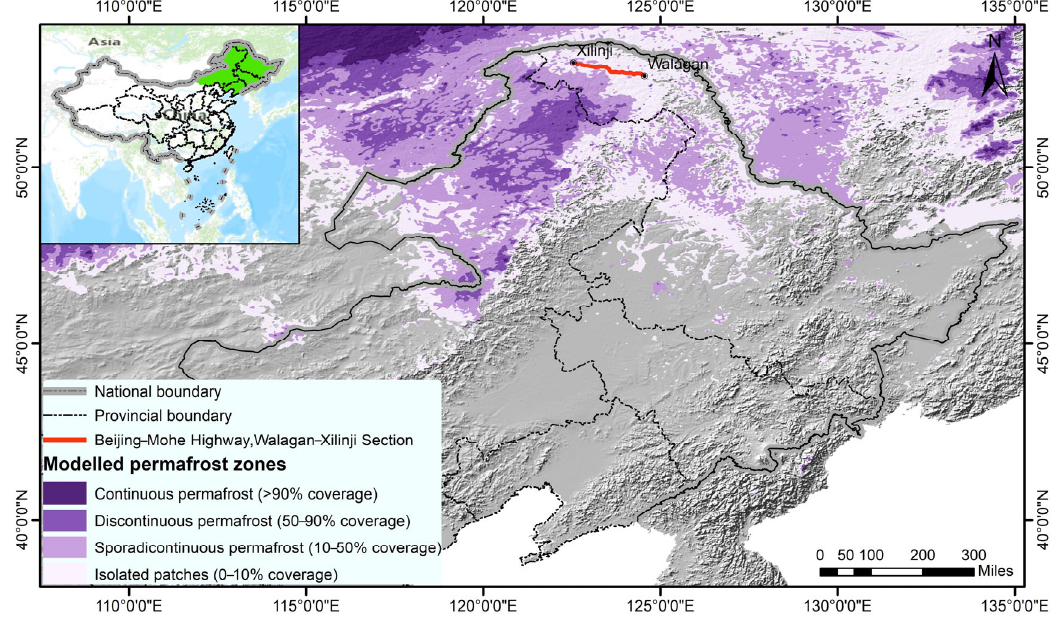
Figure 1. Permafrost distribution in Northeast China and the study area and project location in this paper, with data from Jaroslav O. et al. (2019) [41].